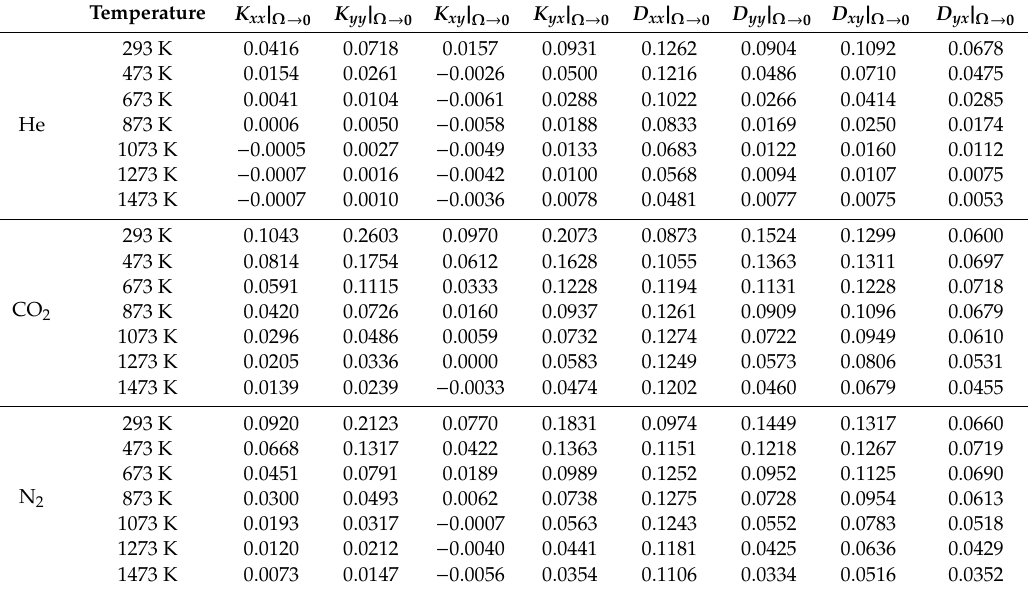
Table 3. Zero dynamic limit coe ffi cients of di ff erent kinds of